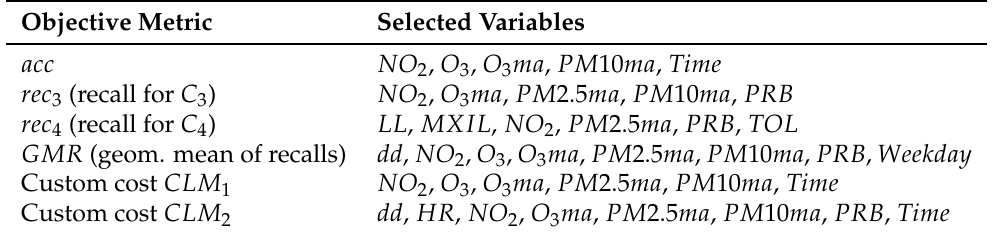
Table 5. Selected variables depending on the optimization objective